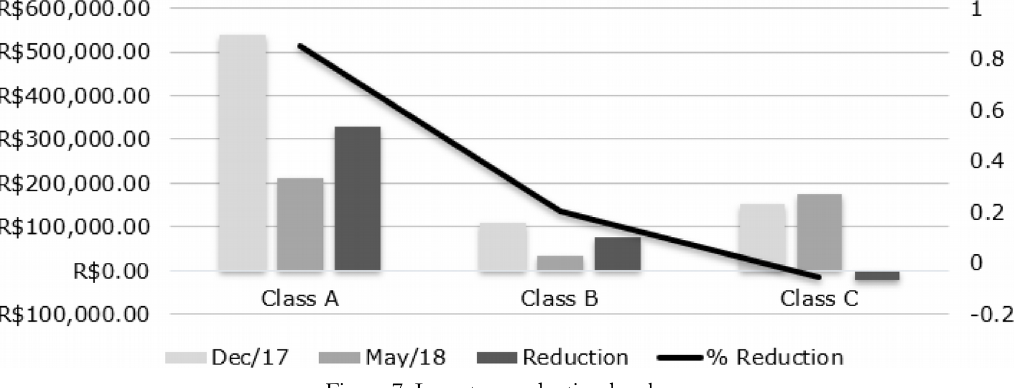
Figure 7. Inventory reduction by class